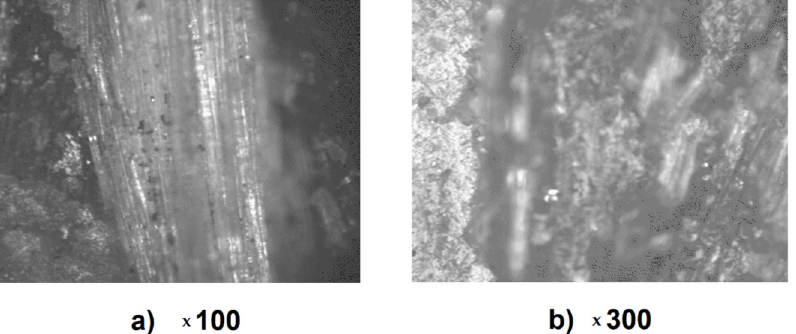
Figure 6. Stuffed material specimens with cure times of 20 min at zoom of ( a ) ×100 and ( b ) ×300.